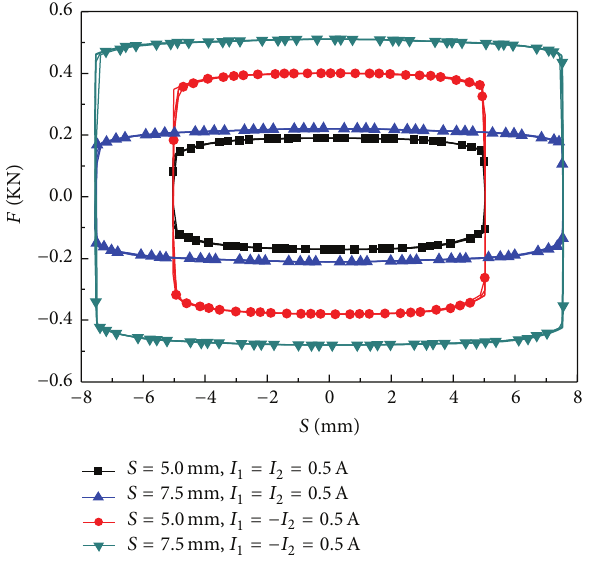
Figure 19: Damping forces under different displacements and different current directions.